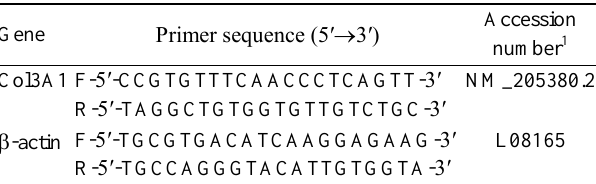
Col3A1 F-5′-CCGTGTTTCAACCCTCAGTT-3′ R-5′-TAGGCTGTGGTGTTGTCTGC-3′